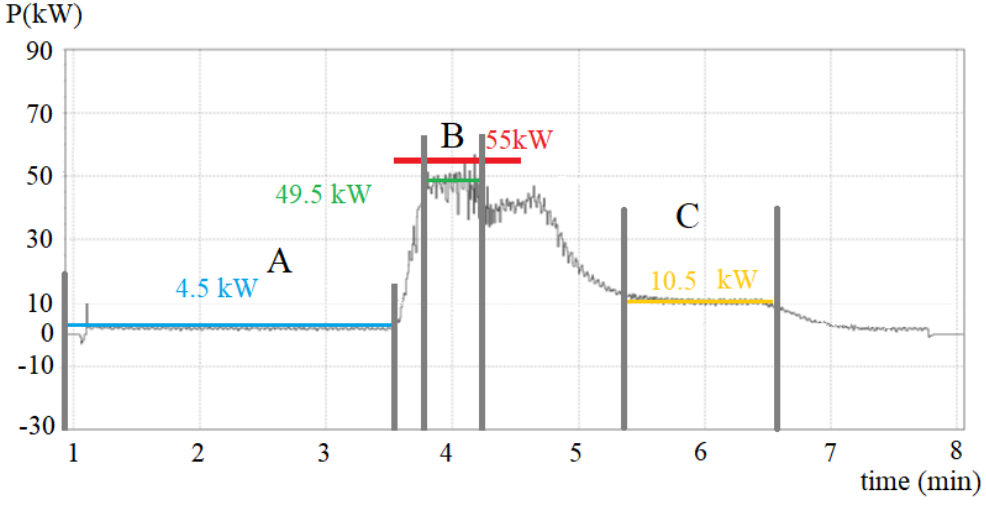
Figure 7. Experimental power consumption curve for the single motor of “Model 1” with indication of power levels.